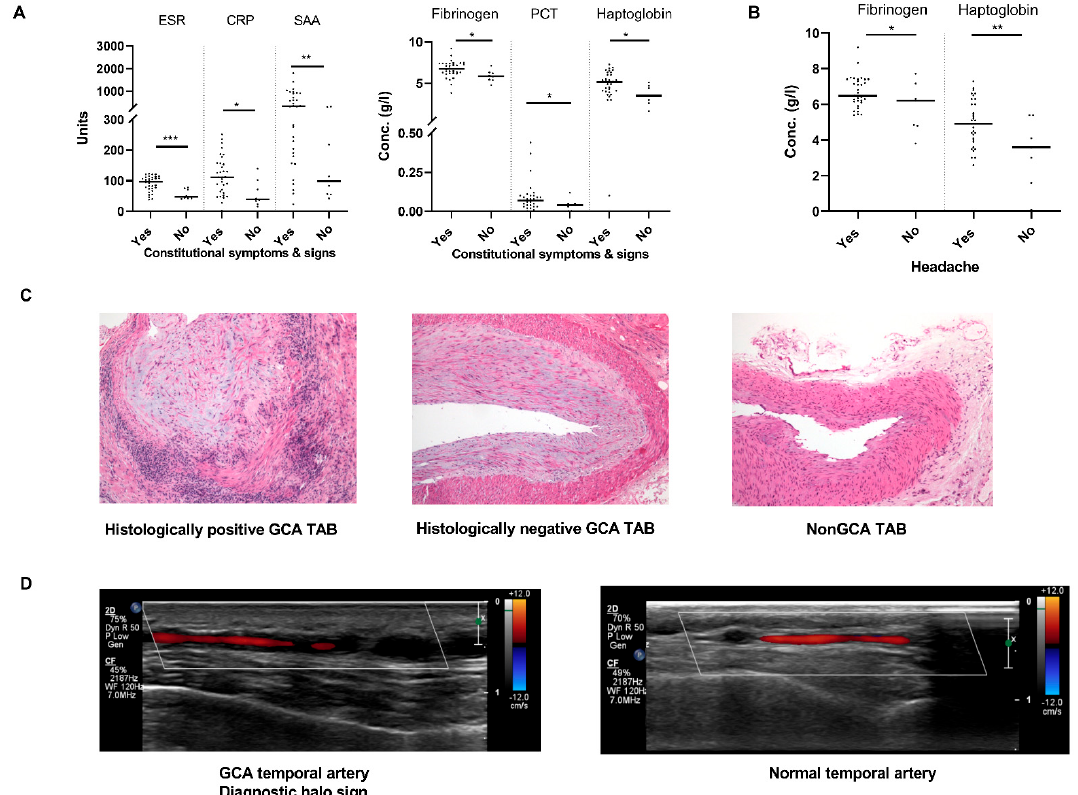
Figure 1. Histological, clinical and laboratory characteristics of GCA patients and nonGCA control subjects. ( A , B ) Differences in systemic inflammatory markers in TAB positive GCA patients ( A ) with and without constitutional symptoms and signs and ( B ) with and without headache. Units used to measure ESR, CRP and SAA in ( A ) were mm/h, g/L, mg/L, respectively. ( C ) Representative HE stainings of histologically positive and negative GCA TABs and normal TABs from nonGCA subjects. Inflammatory cell infiltrates with granulomas are present in histologically positive GCA TABs, but not histologically negative GCA TABs and nonGCA TABs. Histologically positive GCA TABs demonstrate extensive intimal hyperplasia, there is a marked intimal hyperplasia in histologically negative GCA TABs, while the intima is rather thin in non-GCA TABs. ( D ) Representative ultrasound imaging scans of temporal arteries in GCA patients (inflamed temporal artery with a diagnostic halo sign) and control nonGCA subjects (normal temporal artery without a halo sign) * p < 0.05; ** p < 0.01; *** p < 0.001. Legend: ESR, erythrocyte sedimentation rate; CRP, C-reactive protein; SAA, serum amyloid A; GCA, giant cell arteritis; HE, hematoxylin and eosin; PCT, procalcitonin; TAB, temporal artery